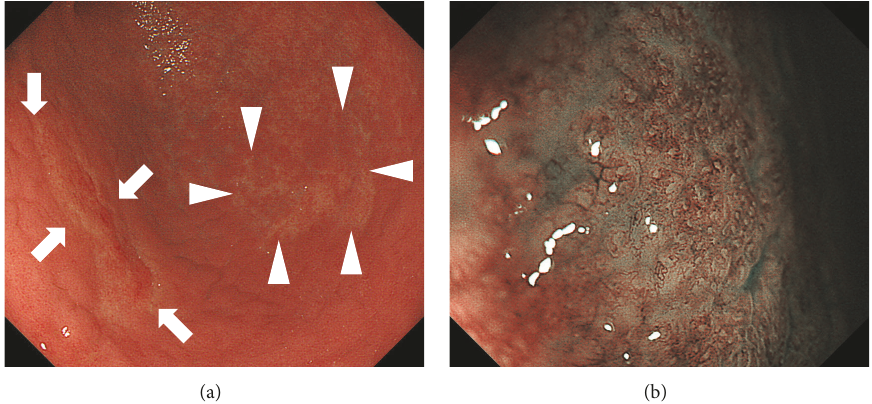
Figure 6: Endoscopic images of typical gastric MALT lymphoma. Two whitish lesions are observed in the gastric body ((a) arrows and arrowheads). Magnifying observation reveals branched vessels and fading of the gastric epithelial structure